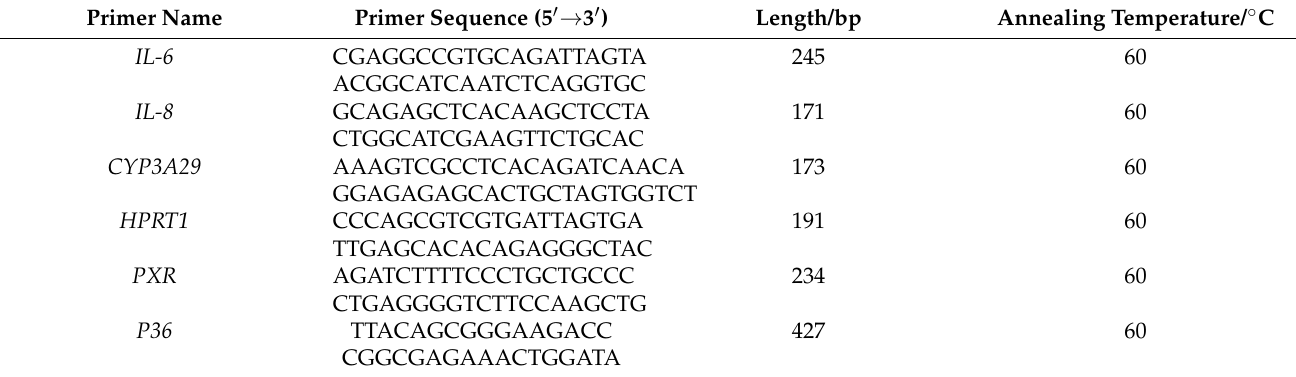
Table 1. Primers used for real-time quantitative polymerase chain reaction (RT-qPCR) amplification. Primer